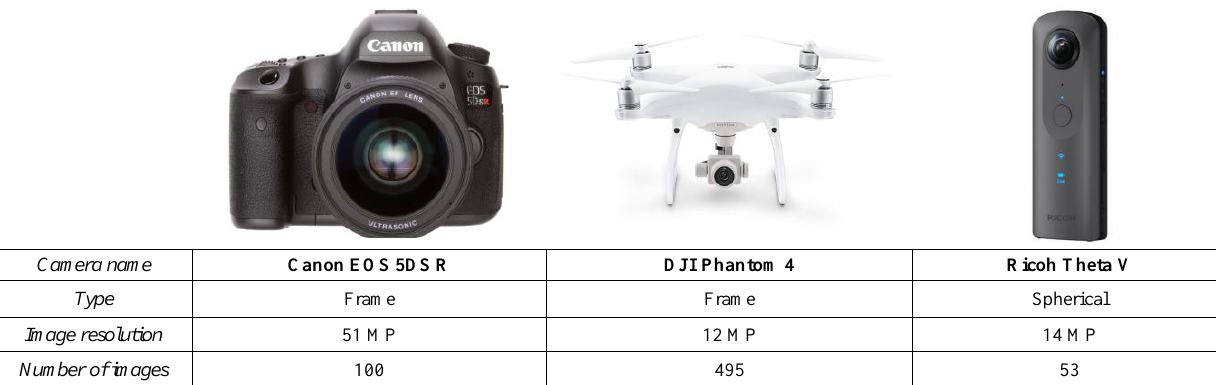
Table 1. The three photogrammetric sensors used in the case study.